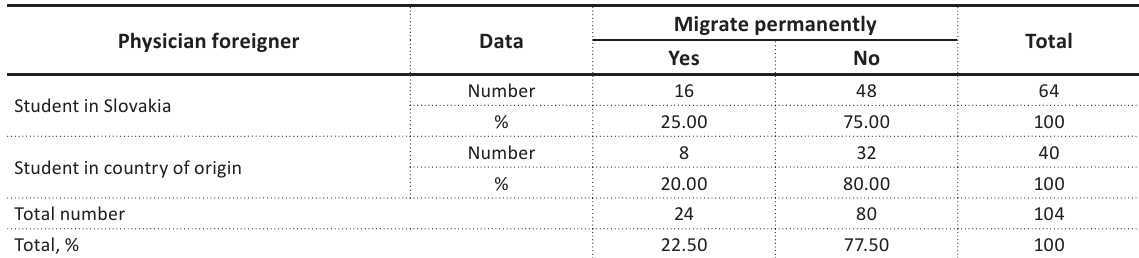
Table 7. Abundance of physicians-foreigners depending on where he/she studied medicine and by the decision to migrate permanently